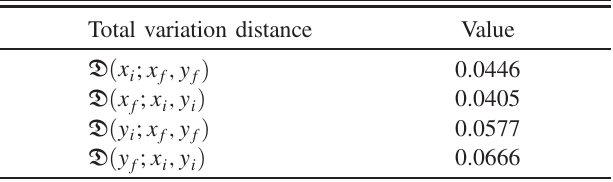
TABLE I. Total variation distances of 1D projections in x y , and y as shown in Fig. 3. i f